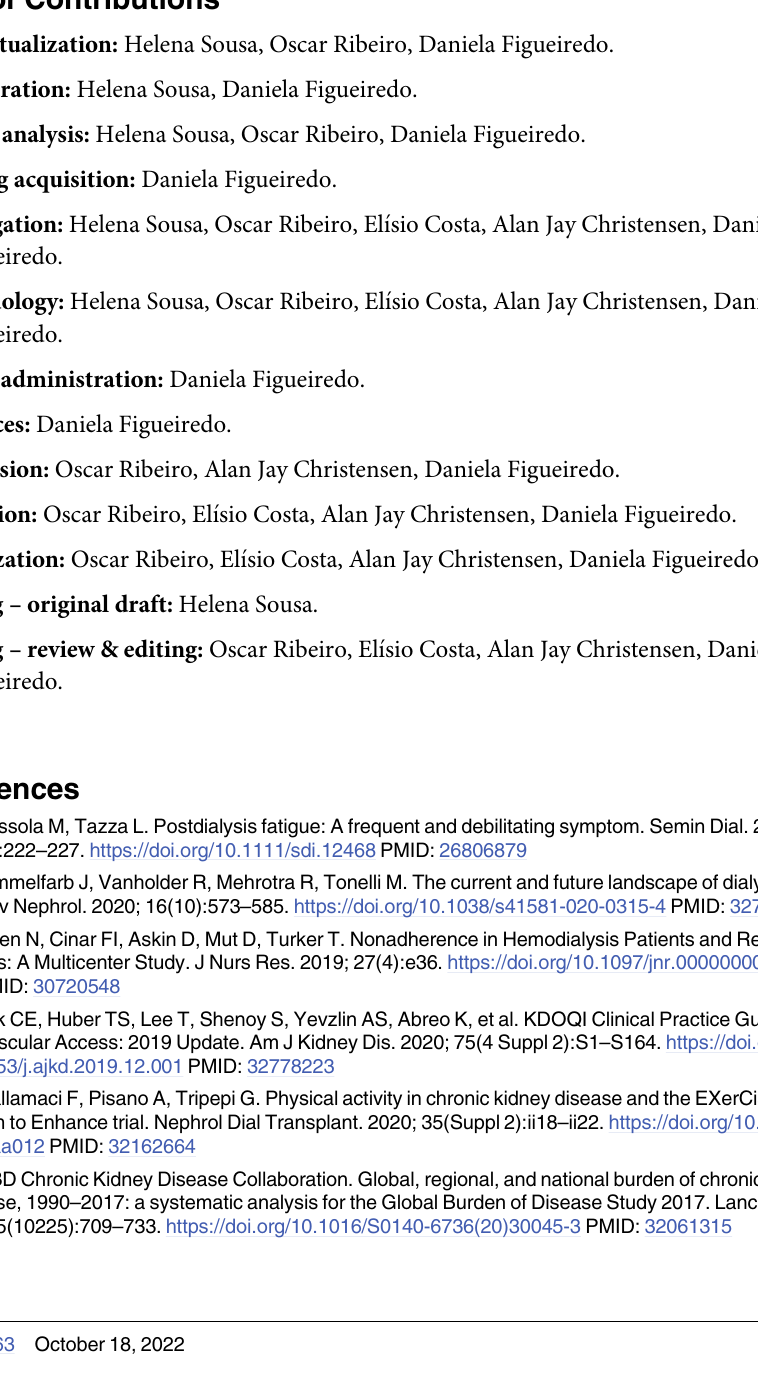
S2 Table. Critical appraisal of the primary studies. (PDF) S3 Table. Confounding factors in primary studies. S4 Table. Summary of each self-report adherence measure analyzed in this systematic